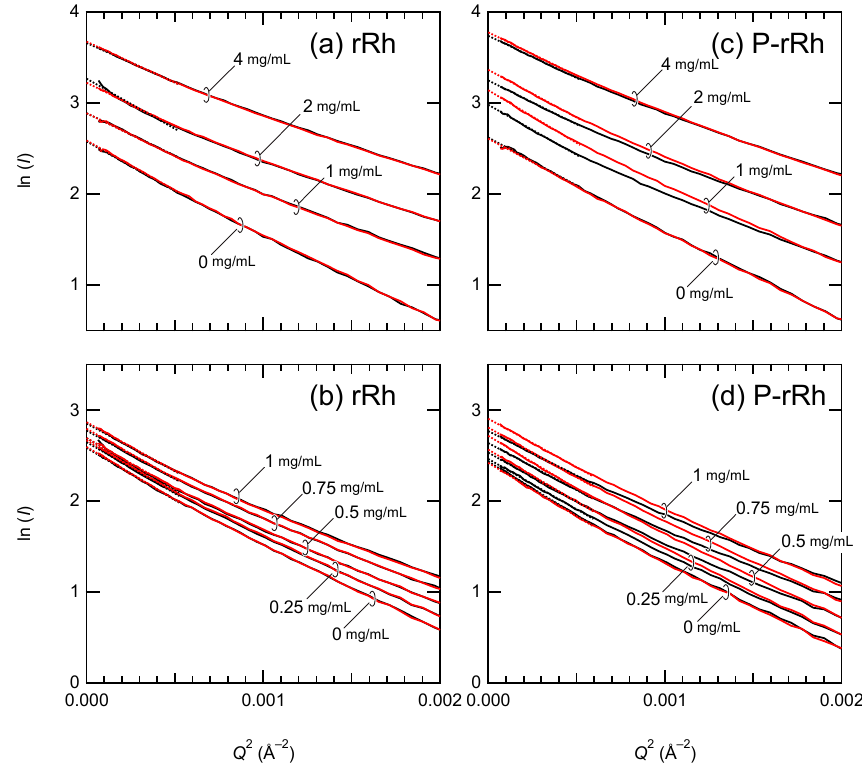
Figure 3. A Guinier plot of the mixture of arrestin and rRh/ND or P-rRh/ND. SAXS profiles were recorded before and after illumination (black and red, respectively). They were Guinier-plotted and linearly extrapolated to Q 2 = 0 to estimate I (0). The concentrations of ( a , b ) rRh/ND and ( c , d ) P- rRh/ND were 20–23 µ M, and those of arrestin (mg/mL) are shown in the